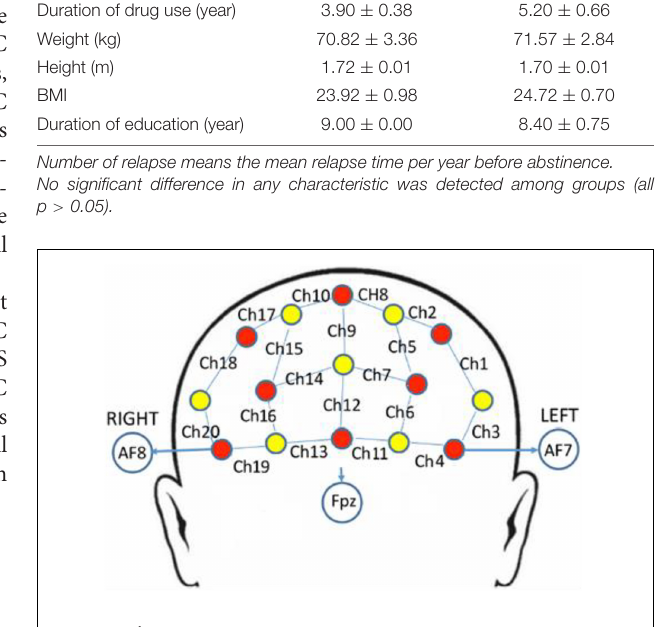
FIGURE 1 | fNIRS channels mapped on the brain. One source (red circles) and one detector (yellow circles) formed a channel (blue lines), and 20 channels were formed (numbered in black, i.e.,